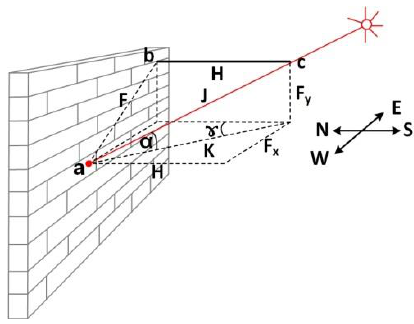
Figure 2. Horizontal pole attached perpendicular to a wall.